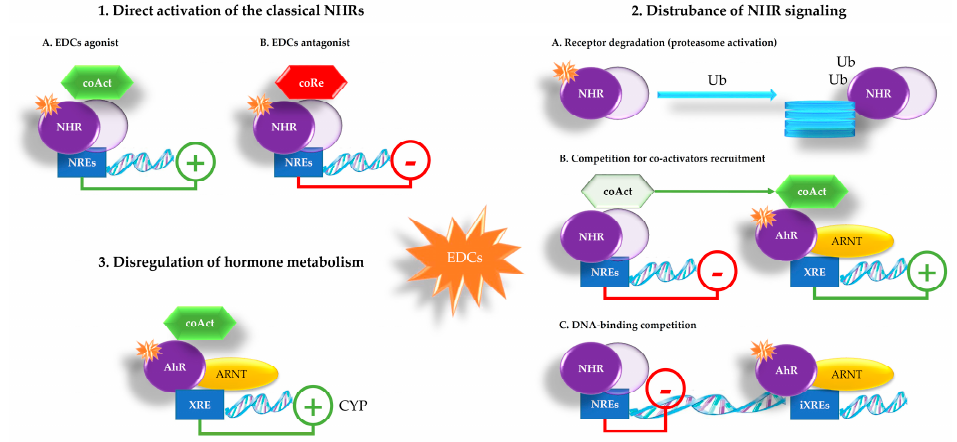
Figure 2. Mechanism of action of EDCs. (1) EDCs can directly bind to NHRs acting as (A) agonists inducing the gene expression or as (B) antagonists inhibiting the receptor activity; (2) EDCs can affect NHRs function by induction of (A) receptor degradation through proteasome activation, (B) competition for coAct recruitment, and (C) DNA-binding competition; (3) EDCs can dysregulate hormone metabolism, mainly inducing degradation of steroid hormones. Abbreviations: AhR, aryl hydrocarbon receptor; ARNT, aryl hydrocarbon receptor nuclear translocator; coAct, co-activators; coRe, co-repressors; CYP, cytochrome P450; EDCs, endocrine-disrupting chemicals; iXRE, inhibitory XRE; NHRs, nuclear hormone receptors; NREs, NHR response elements; Ub, ubiquitin; XRE, xenobiotic responsive element.